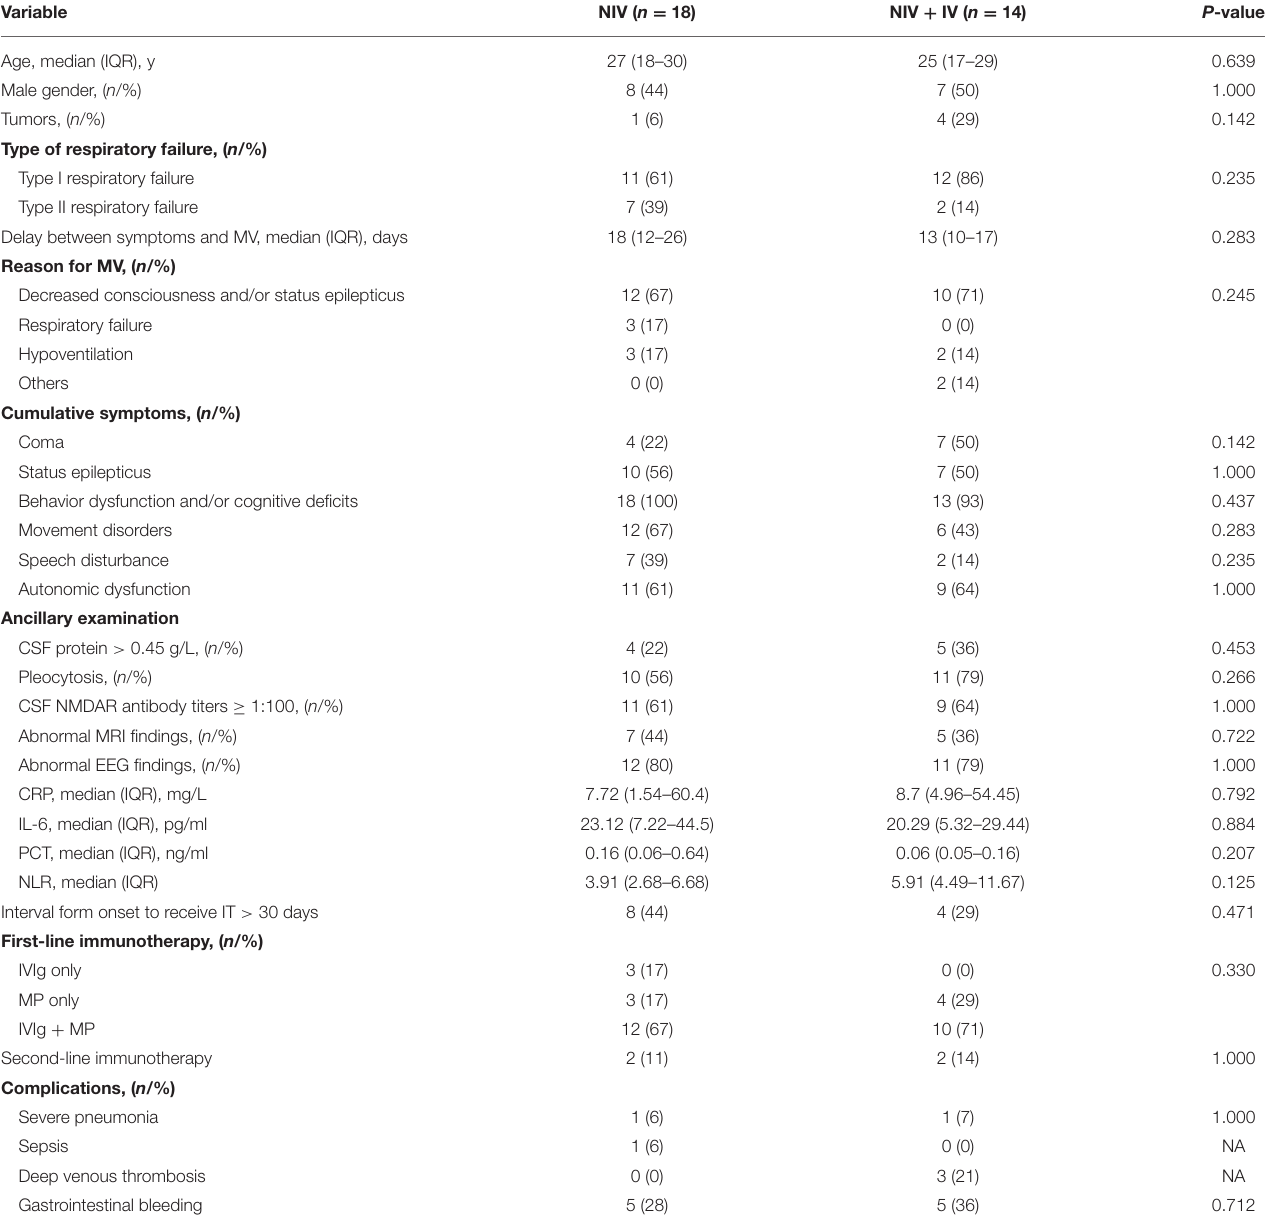
TABLE 2 | Comparison between the non-invasive ventilation and invasive ventilation.